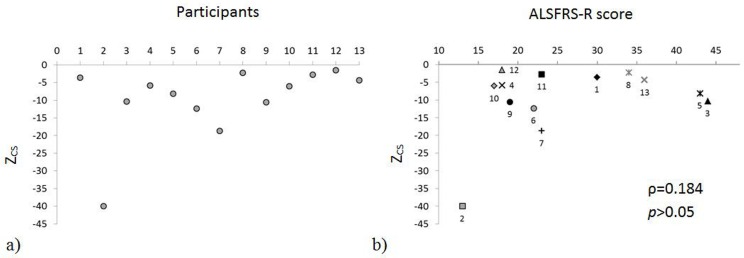
a) ZCS
calculated during the extension from neutral position (E1) reaching the maximum amplitude. b) ZCS
calculated in E1 movement plotted against the ALSFRS-R score given to participants at the time of recording. Numbers close to the markers indicate the participant associated to those Z and ALSFRS-R scores. ρ = Spearman’s rank correlation coefficient. Level of significance for the correlation between ZCS and ALSFRS-R score: p < 0.05.